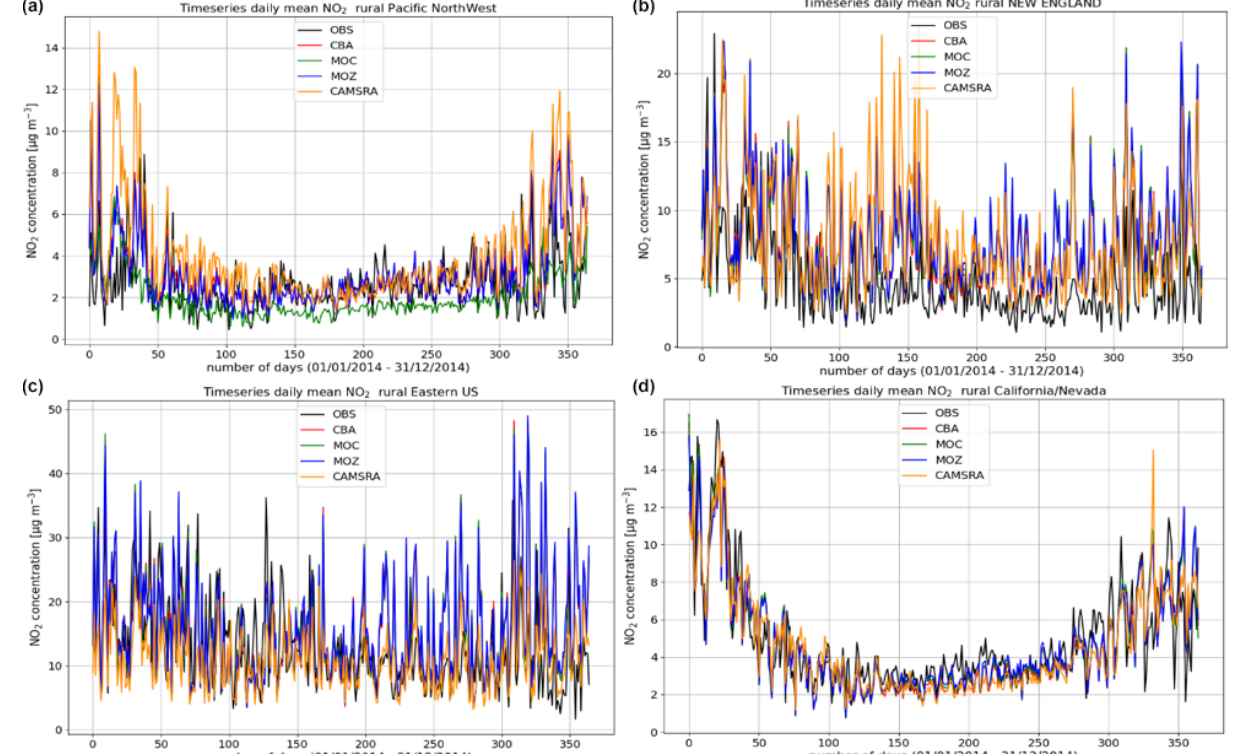
Figure 13. The same as Fig. 5 but for surface NO 2